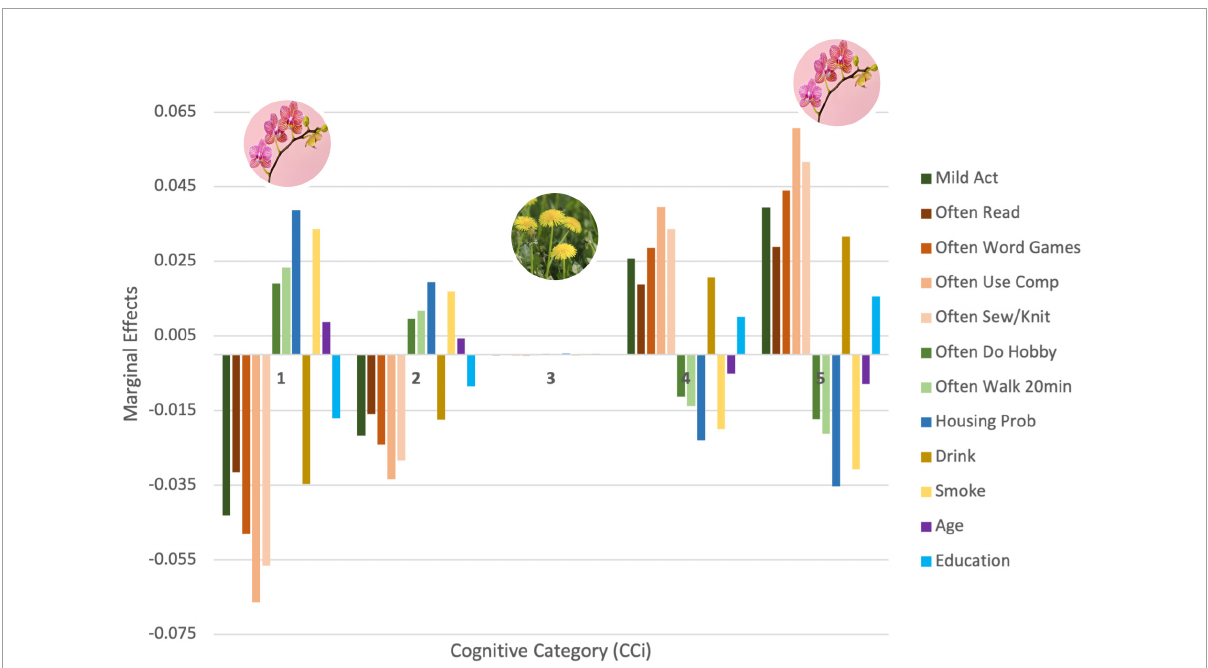
FIGURE1 Relationship between lifestyle factors and different cognitive categories. The figure is color coded based on similarity of covariate. In dark blue are the factors related to financial strain, in shades of orange are the factors that require greater levels of concentration, in shades of green are the factors that relate to physical exercise, in purple and light blue is age and level of education, and in shades of yellow is smoking and